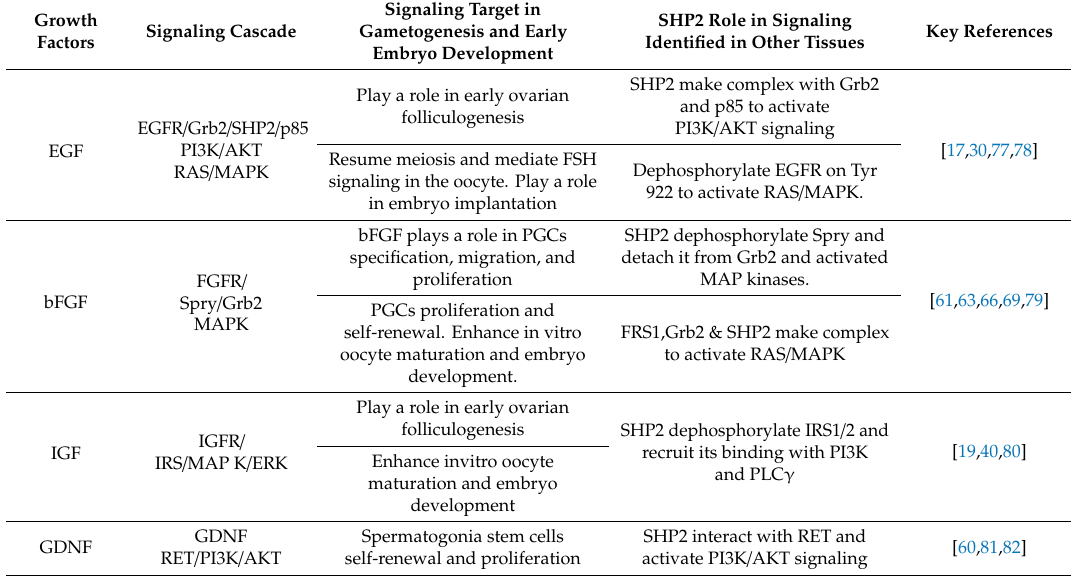
Table 1. Growth factors SHP2 dependent signaling and involvement in gametogenesis, gametes maturation, early embryo development, and implantation.